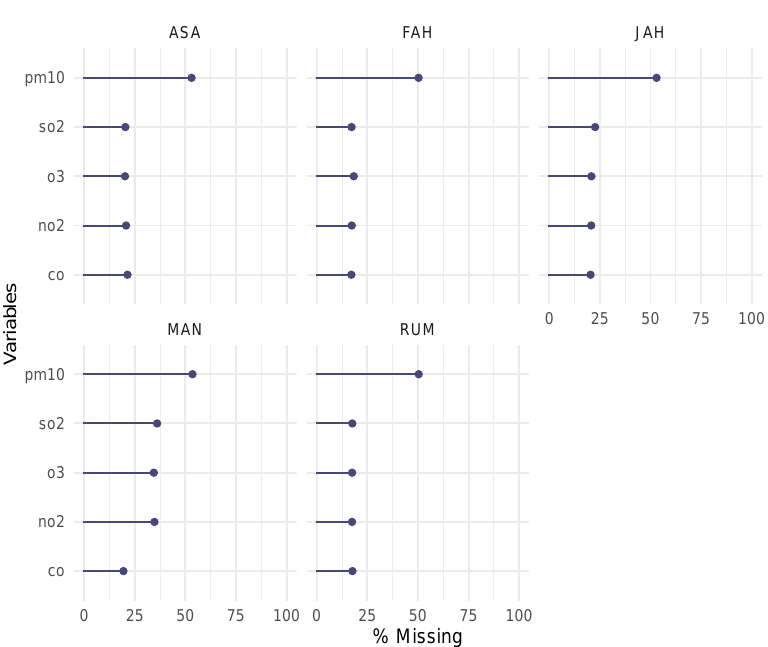
Figure A1. Missing values for air quality pollutants from 2012 to 2017 per fixed station.